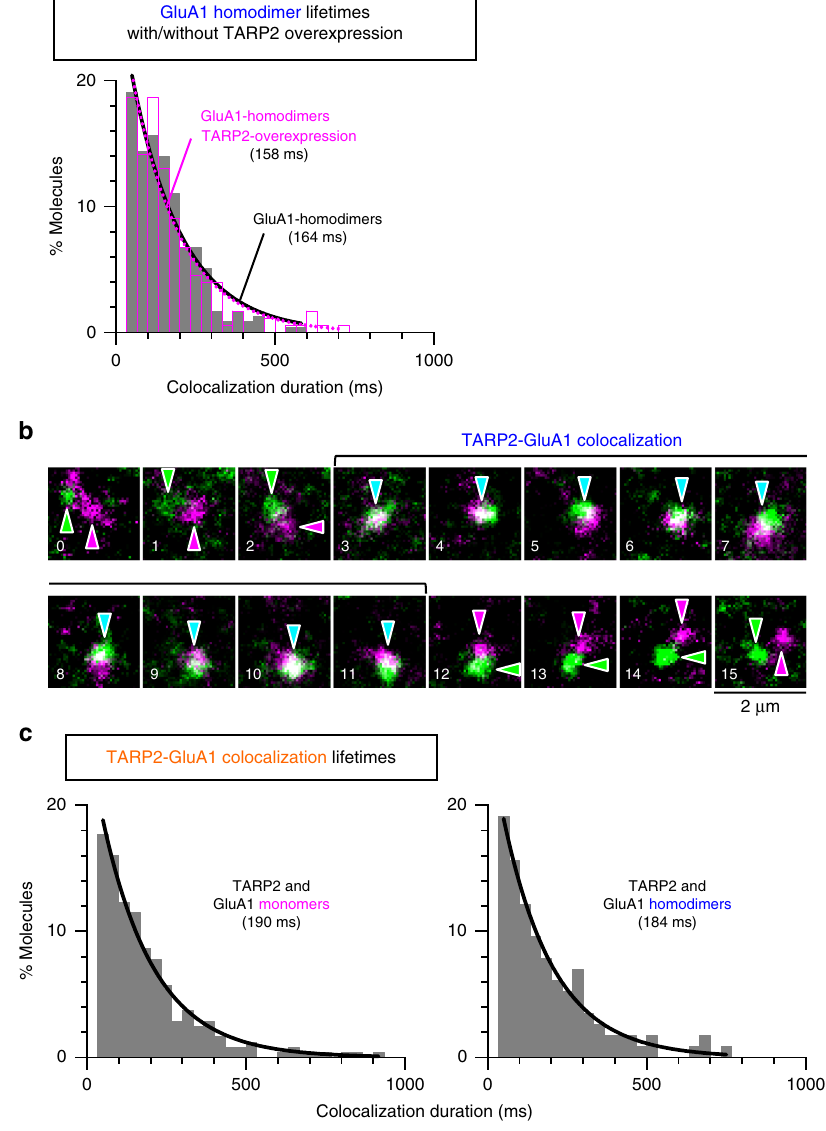
Fig. 5 TARP2 dynamically forms metastable complexes with GluA1. a The distributions of homodimer durations of ACP-GluA1 in the HEK293-PM with (magenta) and without (gray, see Fig. 3d) TARP2-mGFP overexpression (expression levels 47 (±30) times higher than those of ACP-GluA1; n = 13 cells). b Typical single fl uorescent-molecule image sequences, showing that a TARP2-mGFP monomer (green arrowheads) formed a transient heteromer with an ACP-GluA1 monomer (magenta arrowheads) in the HEK293-PM (a typical result from 358 independent movies). Cyan arrowheads indicate the heteromer. c The duration distributions of the heteromers of TARP2-mGFP with ACP-GluA1 monomers (left) and dimers (right) in the HEK293-PM. The histograms could be fi tted well with single exponential decay functions, providing the heteromer lifetimes, which are shown in parentheses (after correction for the probe photobleaching lifetimes). Related ACP-GluA2 results are shown in Supplementary Fig. 10. For statistical parameters, see Supplementary Table